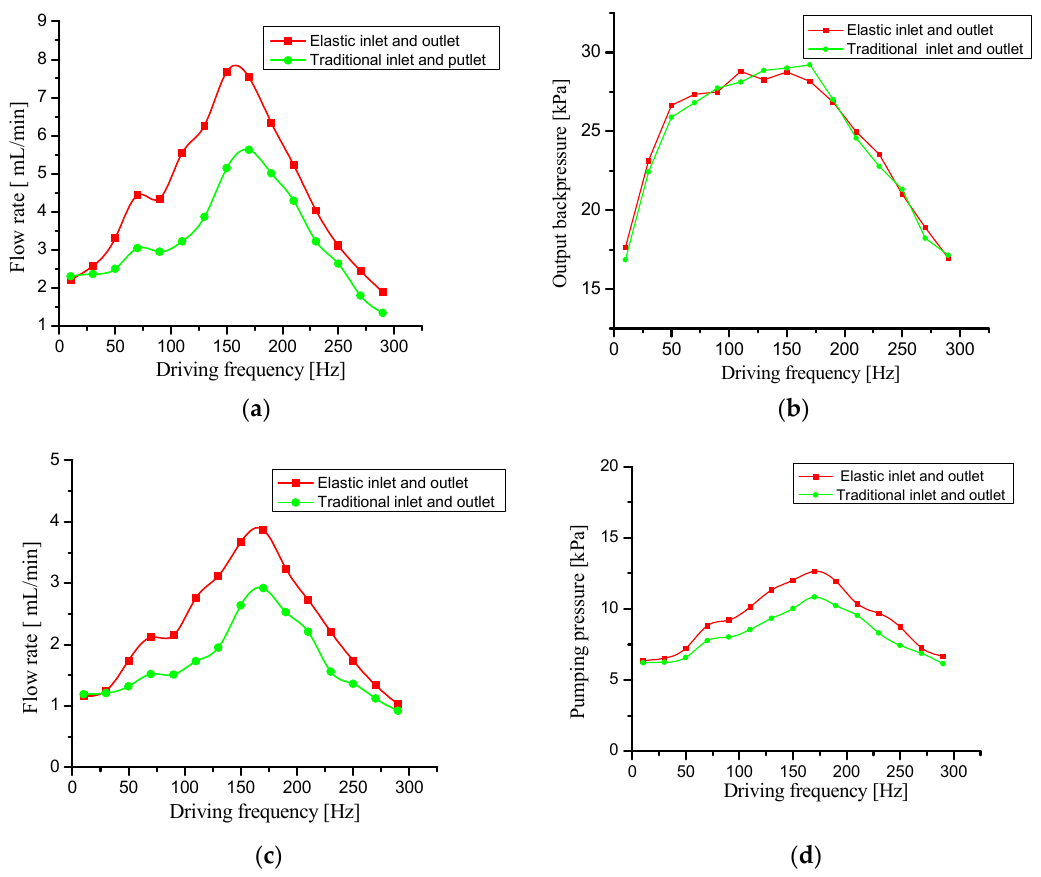
Figure 15. Performance comparison test curves of the prototypes with and without elastic inlet and outlet. ( a ) Flow rate—driving frequency curves with needle valve fully open, ( b ) output backpressure—driving frequency curves with needle valve fully closed, ( c ) flow rate—driving frequency curves with 50% needle valve opening, and ( d ) output backpressure—driving frequency curves with 50% needle valve opening.